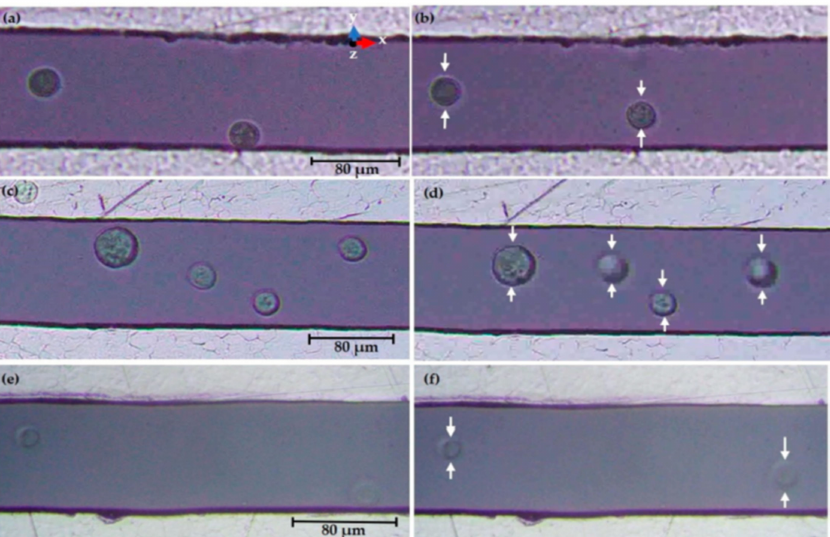
Figure 6. Fluorescence microscopy observations of keratinocytes in DMEM/F-12 conductive medium showed that the keratinocytes experienced dielectrophorectic force and migrated to the area of lowest electric field strength, which was the middle between electrodes at a final 10 VPP at 300 kHz ( b ), 800 kHz ( d ), and 15 MHz ( f ) compared to the initial 0 VPP at 300 kHz ( a ), 800 kHz ( c ), and 15 MHz ( e ). Image is adapted with permission from Deivasigamani et al.